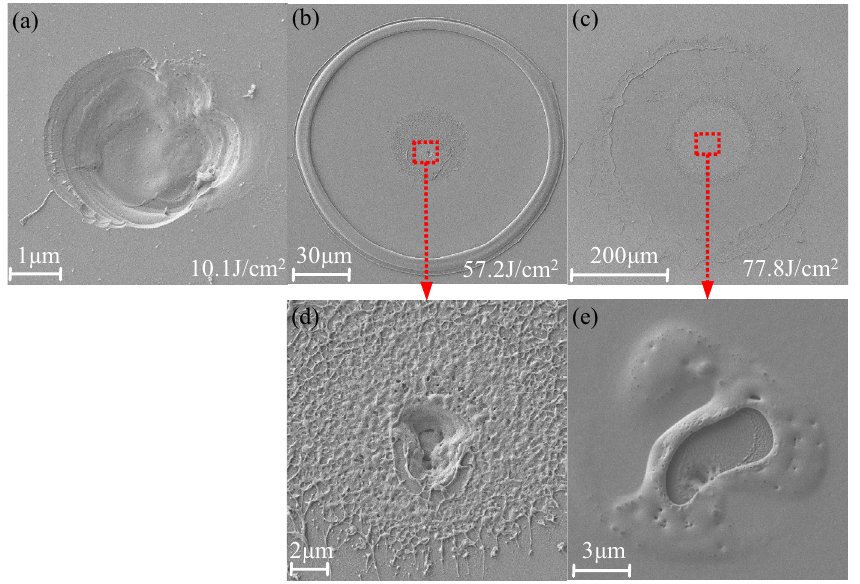
Figure 4. SEM morphologies of Al 2 O 3 /SiO 2 coatings after laser irradiation: ( a ) close to laser damage threshold; ( b ) middle laser fluence; ( c ) high laser fluence; ( d ) and ( e ) are enlarged images of the center area of ( b ) and ( c ), respectively.